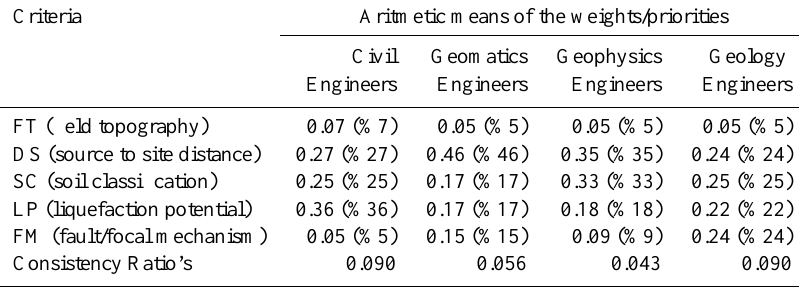
Table 5. Aritmetic Means of Respondents with respect to their disciplines.